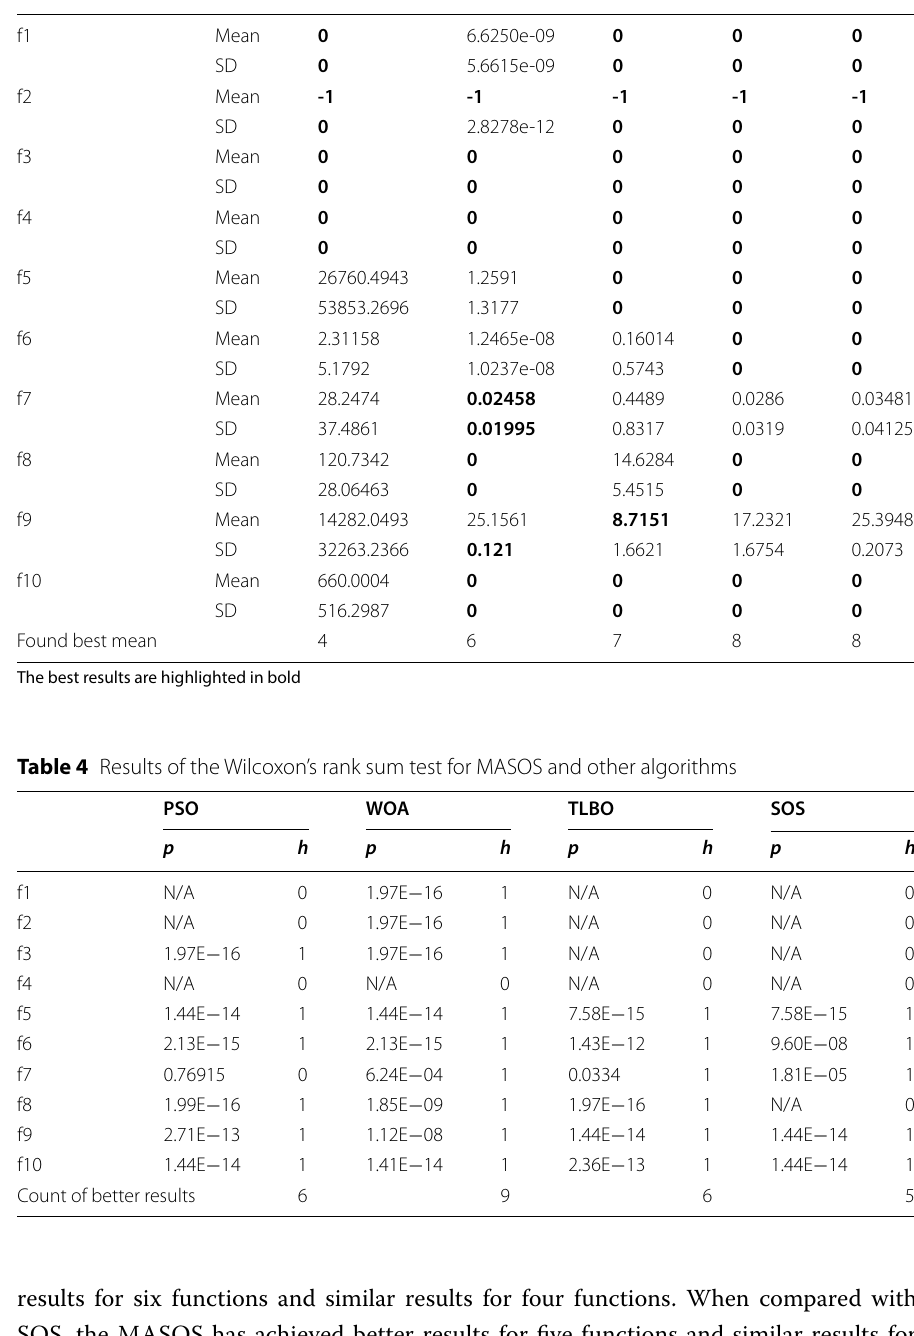
Table 3 Statistical results for benchmark functions Function